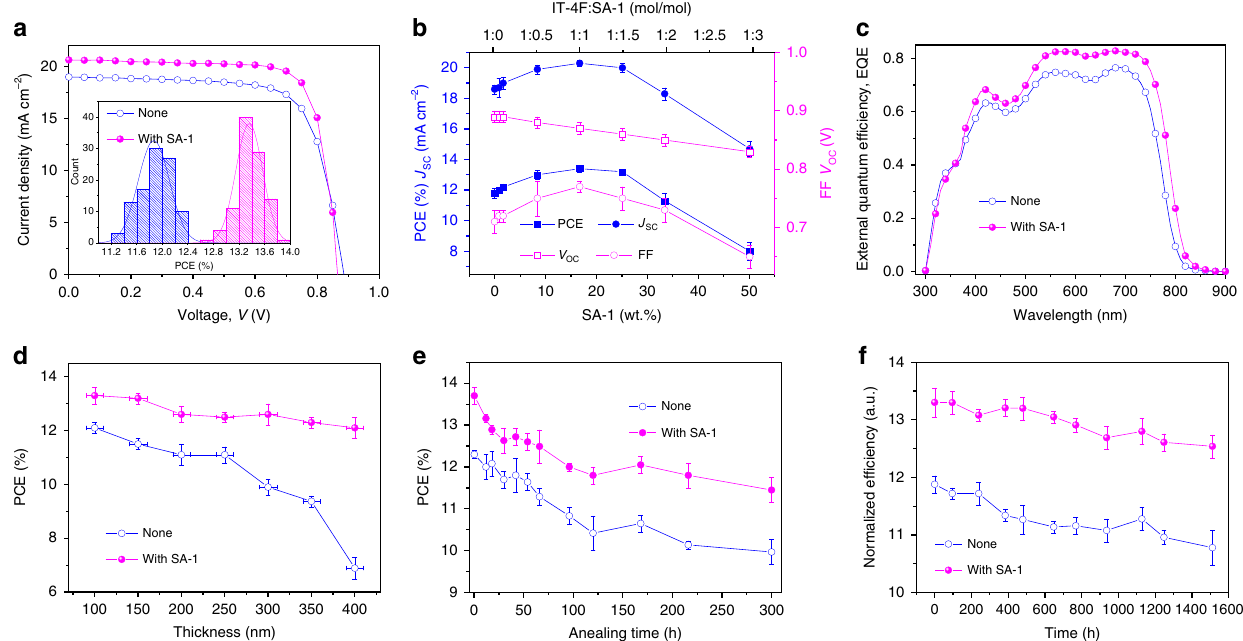
Fig. 2 Device performance. a J − V curves and the histogram of PCE for PBDB-TF:IT-4F-based devices with/without SA-1. Thermal annealing of the active fi lms at 140 °C for 10 min was performed. b Device parameters of PBDB-TF:IT-4F devices as a function of the mole ratios of IT-4F:SA-1 or the weight ratio of SA-1 incorporated into the casting solution (error bars show standard deviation from the mean). c EQE curves of the corresponding devices. d PCEs of the devices based on PBDB-TF:IT-4F processed with or without SA-1 under various active layer thicknesses (the horizontal error bars represent the standard deviation of the thicknesses and the vertical error bars show standard deviation from the mean). e , the thermal stability of OSC devices processed with or without SA-1 (error bars show standard deviation from the mean). f The long-term storage stability of OSC devices processed with or without SA- 1 (error bars show standard deviation from the mean) Table 1 The effect of SA-1 on the photovoltaic parameters of devices based on different active layers Active layer SA-1 a (wt.%)